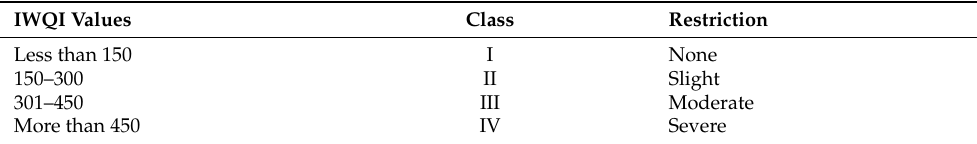
Table 3. Categorization of Water Quality Index (IWQI) of irrigation water.